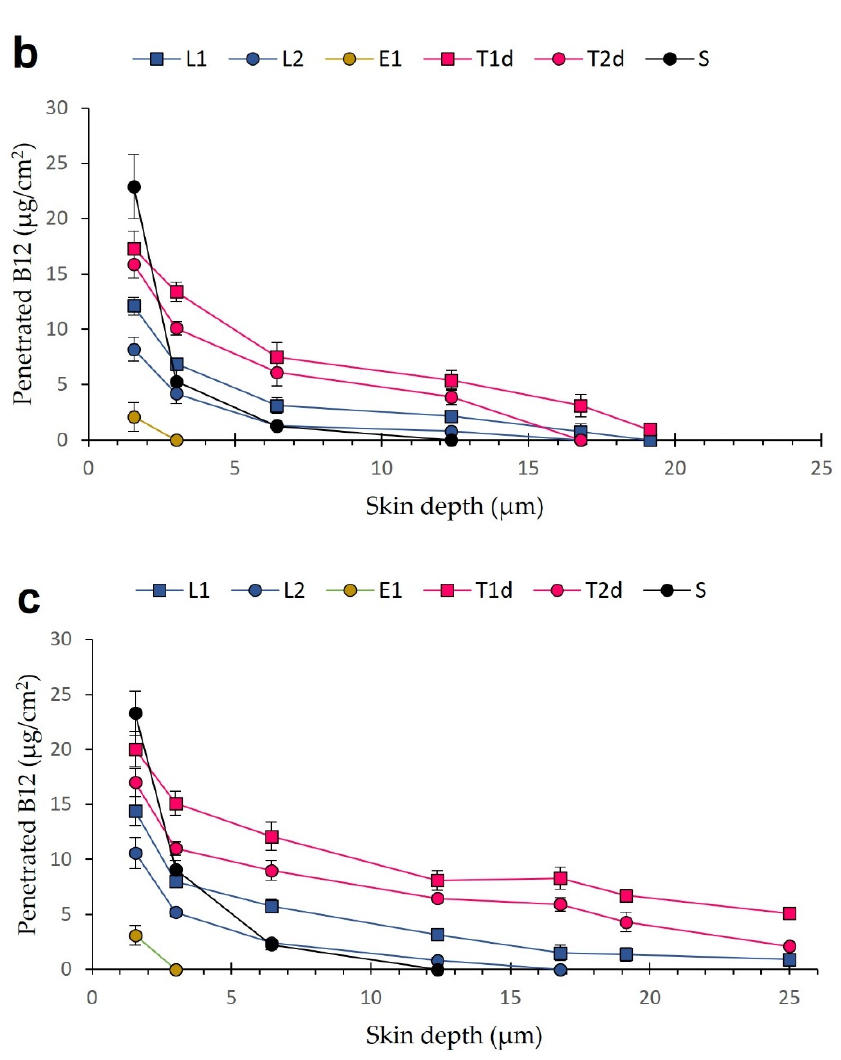
Figure 8. Penetration profiles of B12 delivered from liposomes, transferosomes, ethosomes, and solution after 2 h ( a ), 4 h ( b ), and 6 h ( c ). All results are expressed as mean ± SD ( n = 3).